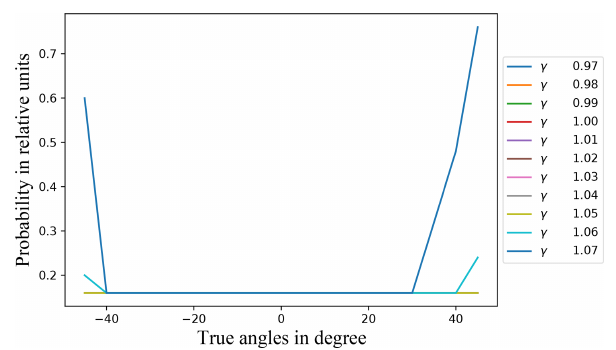
Figure 7. Probability of the algorithm producing no result after one complete execution for each value of γ